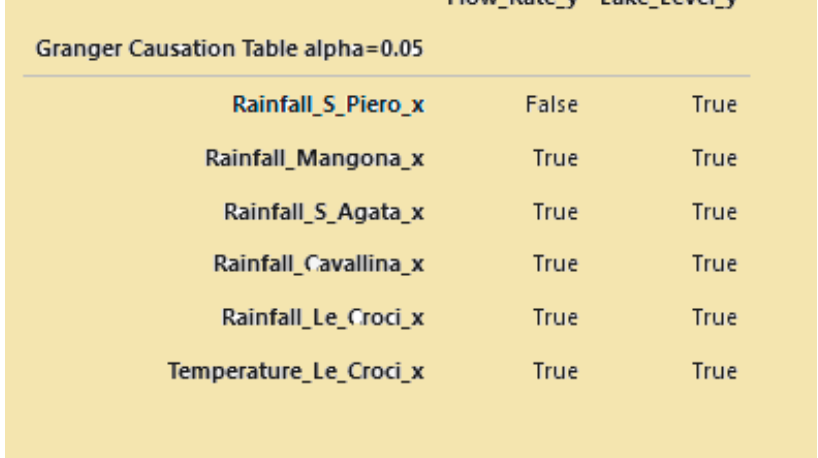
Figure 4. An example of the Granger Causality test (Bilancino-Lake).